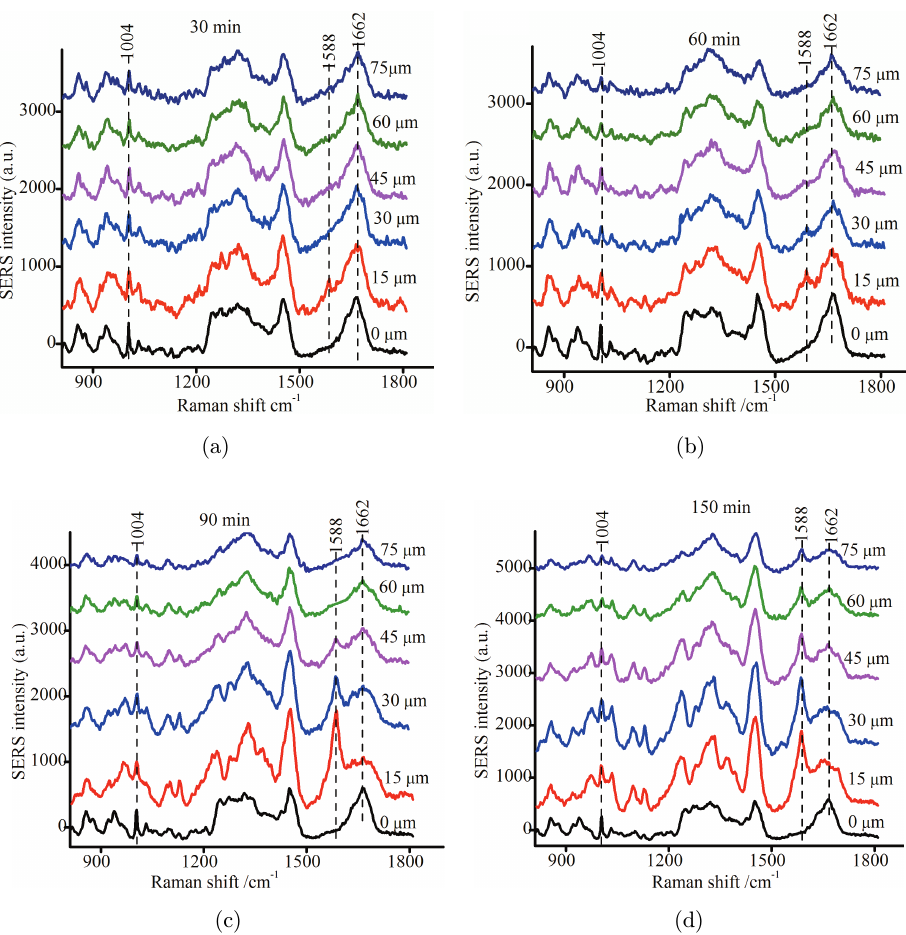
Fig. 5. A series of SERS spectra of rat skin at 0, 15, 30, 45, 60, and 75 (cid:1) m below the surface after the application of GNPs at various time intervals of (a) 30, (b) 60, (c) 90, and (d) 150 min. The peak at 1588 cm (cid:1) 1 from citrate group was used as GNA